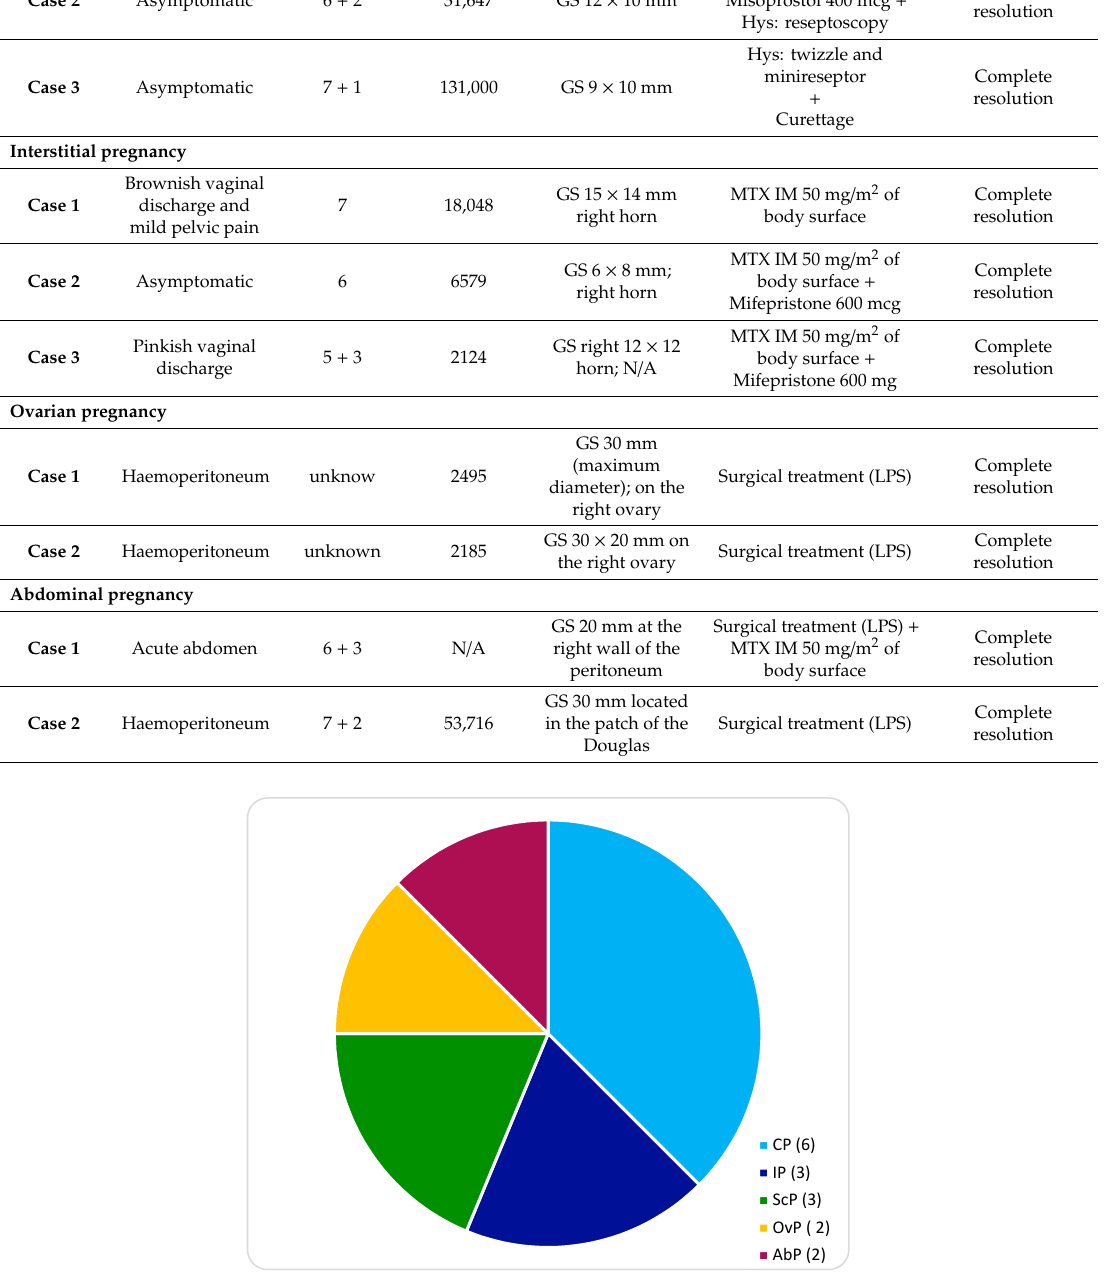
Figure 1. Non-tubal ectopic distribution by location in our center: Cervical pregnancy (CP); Interstitial pregnancy (IP); Scar pregnancy (ScP); Ovarian pregnancy (OvP); Abdominal pregnancy (AbP).